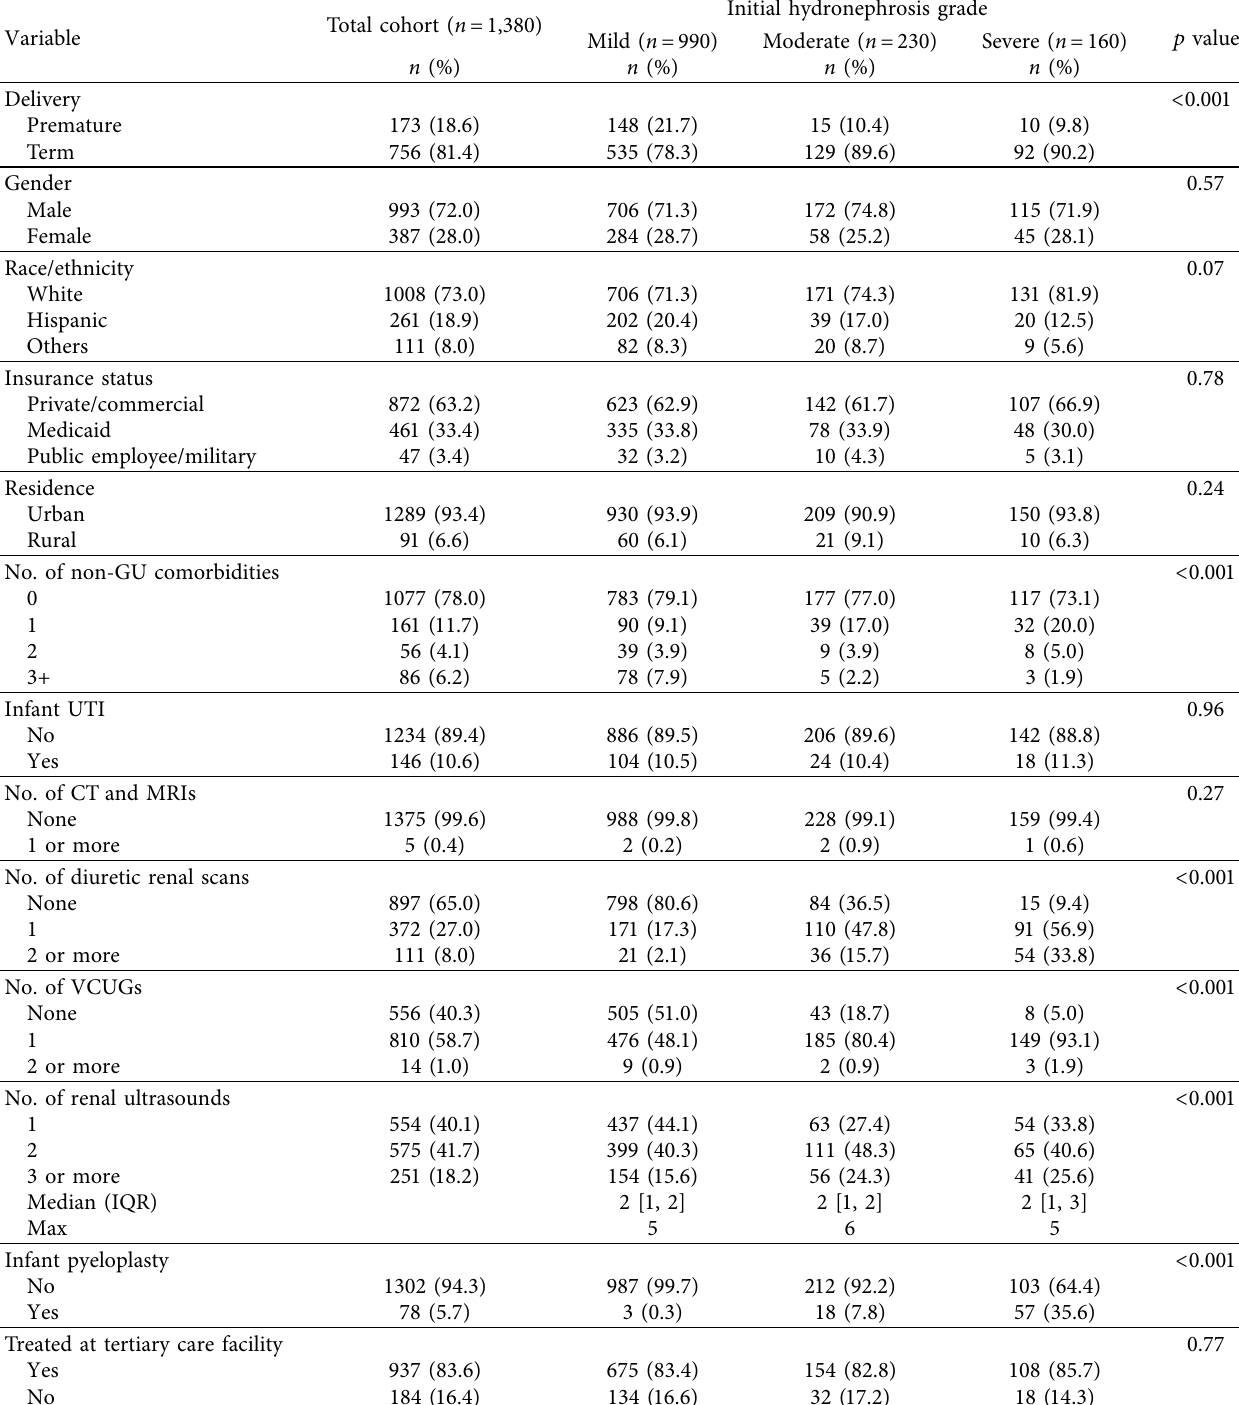
Table 1: Demographics of infant hydronephrosis